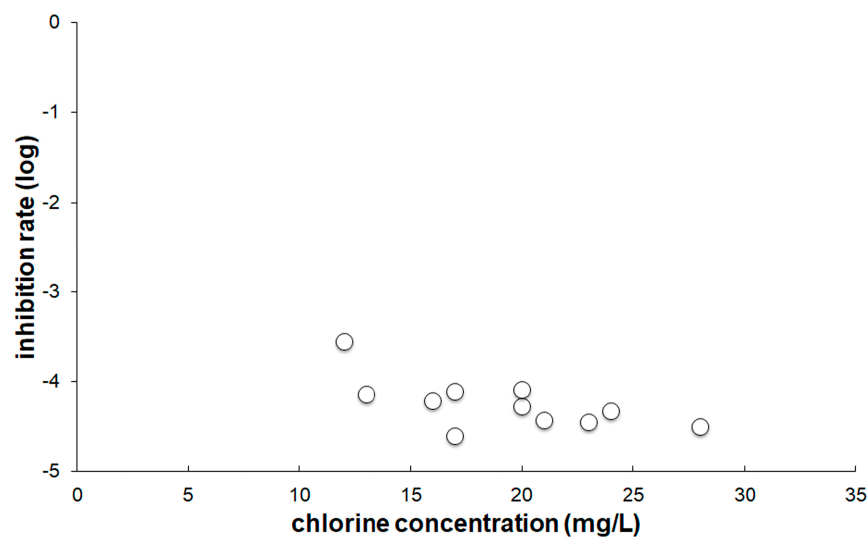
Figure 3. In vitro disinfection activity of SAEW on B. subtilis . The inhibition rate was calculated the same way with E. coli .